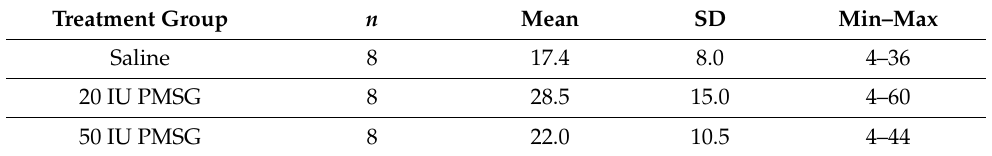
Table 7. Differences in normal spermatozoa morphology (% total morphology) by treatment